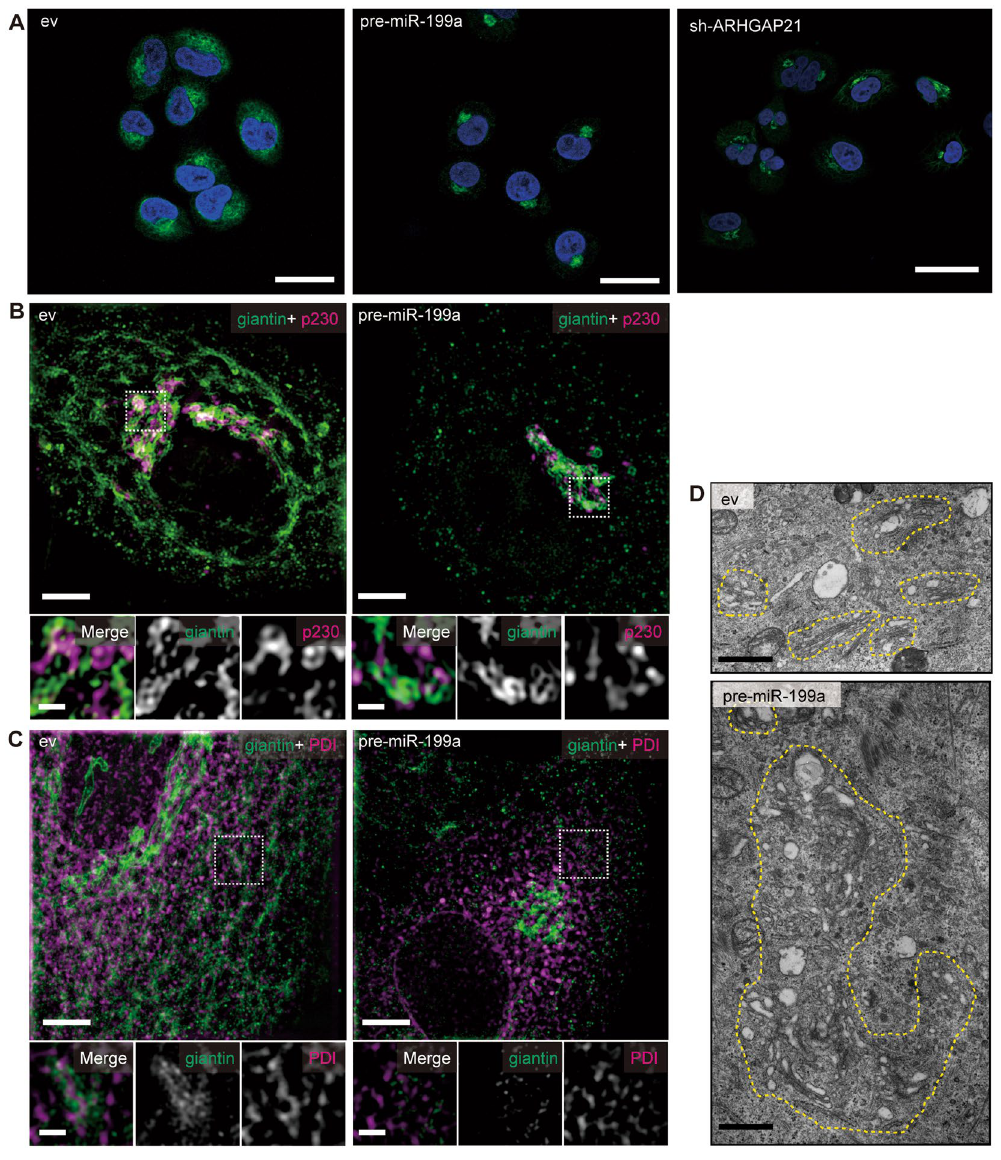
Figure 6. Exogenous expression of miR-199a or sh-ARHGAP21 in A549 cells alters the Golgi structure and function. ( A ) Representative confocal microscopy images of A549 cells transduced with control (ev), pre- miR-199a-, or sh-ARHGAP21#01-expressing lentivirus vector. Cells were stained with anti-giantin antibody (green) and DAPI (blue). In sh-ARHGAP21-expressing cells, the arrowhead indicates a cell with condensed distribution of giantin, and the arrow indicates a cell with meshwork distribution of giantin. Magnifications are shown in the lower panels (bars, 5 µ m). ( B and C ) Representative super-resolution images of A549 cells transfected with control (ev) or pre-miR-199a-expressing lentivirus vector stained with anti-giantin antibody (green) in combination with anti-p230 antibody ( B , magenta) or anti-PDI antibody ( C , magenta). The upper panels show z-stack images reconstructed by maximum intensity projection (bars, 5 µ m) and the lower panels show magnifications of the areas boxed with dashed lines in the upper panels (bars, 1 µ m). ( D ) Representative transmission electron micrographs of A549 cells transfected with control (ev) or pre-miR-199a-expressing lentivirus vector (bars, 1 µ m). Areas enclosed by dashed yellow lines indicate the Golgi